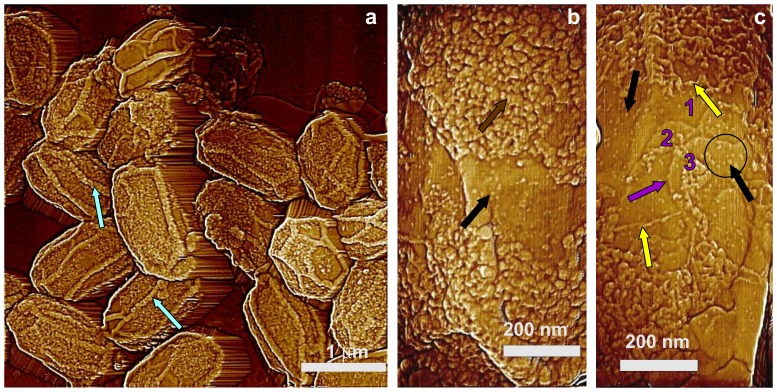
AFM images of cotO spores.(a) Height image of spores with surface ridges extending along the entire length of spores (light blue arrows). (b,c) High-resolution height images of areas on surfaces of single spores showing a dense fiber structure forming a granular structure (b; brown arrow) and individual fibers (c; light yellow arrows). In panel (c), three layers (terraces) of inner coat structure are numbered 1, 2, and 3 in purple. Step edges representing boundaries of each layer (one marked with a purple arrow) are visible. In panels (b) and (c), nanodots are marked with black arrows and one area with a high density of nanodots is circled in panel (c).